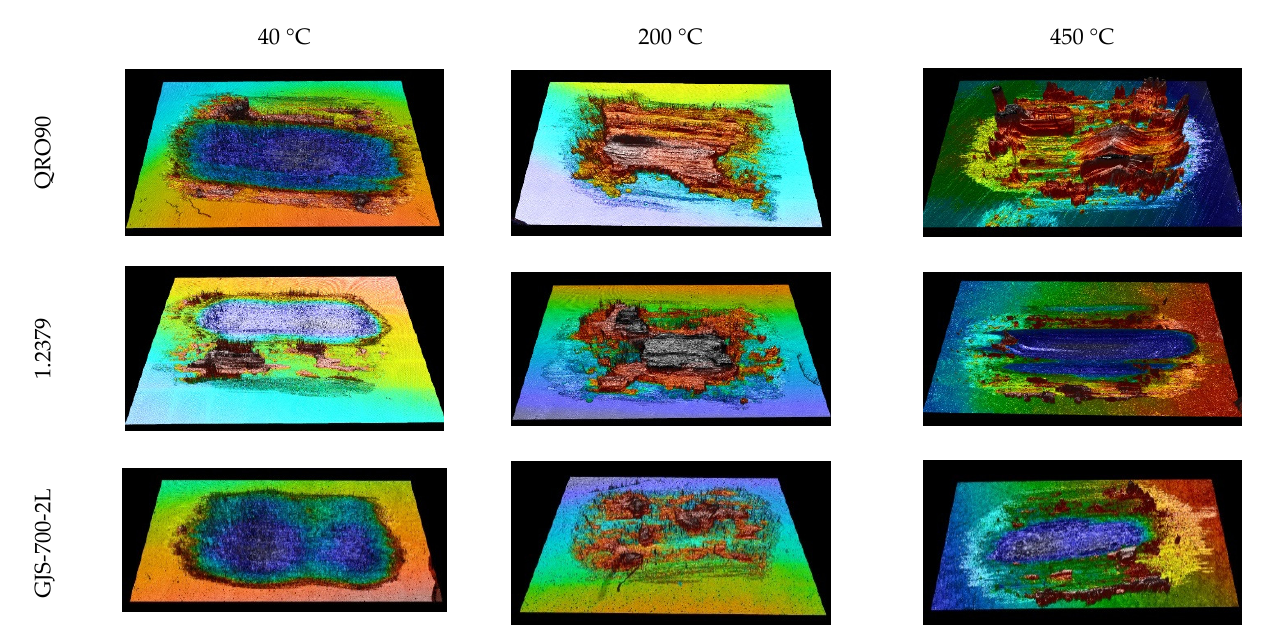
Figure 6. Wear tracks for disks tested against 6026 pins.